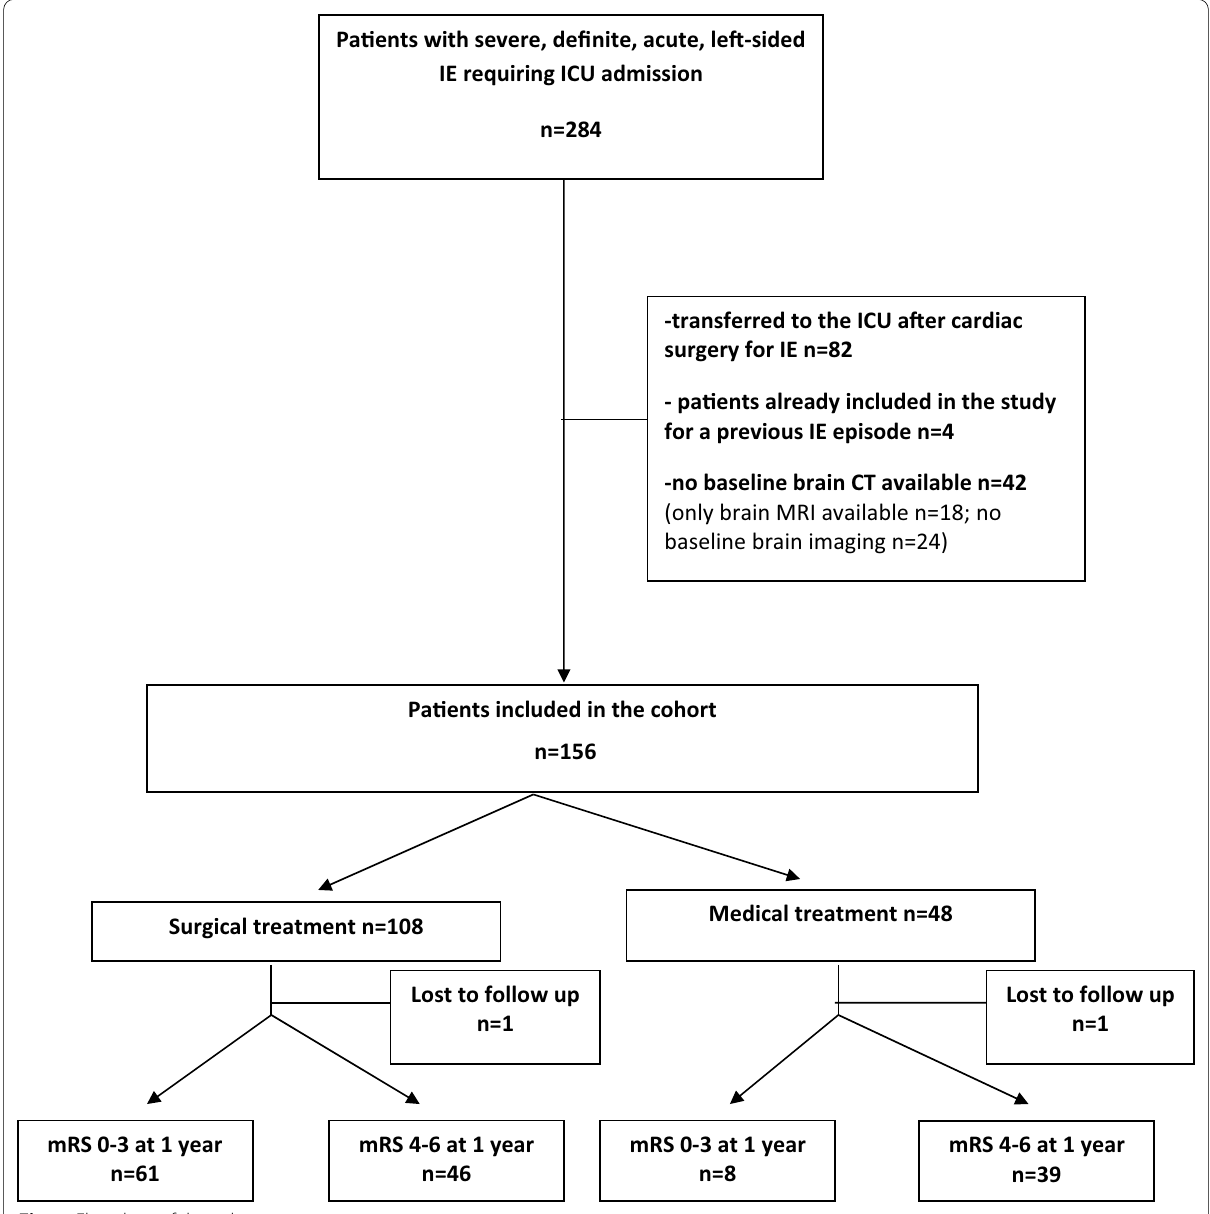
Fig. 1 Flowchart of the